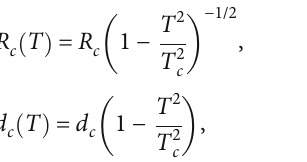
ð θ Þ for α s = 0 : 12 , 0.24, 0.48, and 0.96 as a function of R and θ m